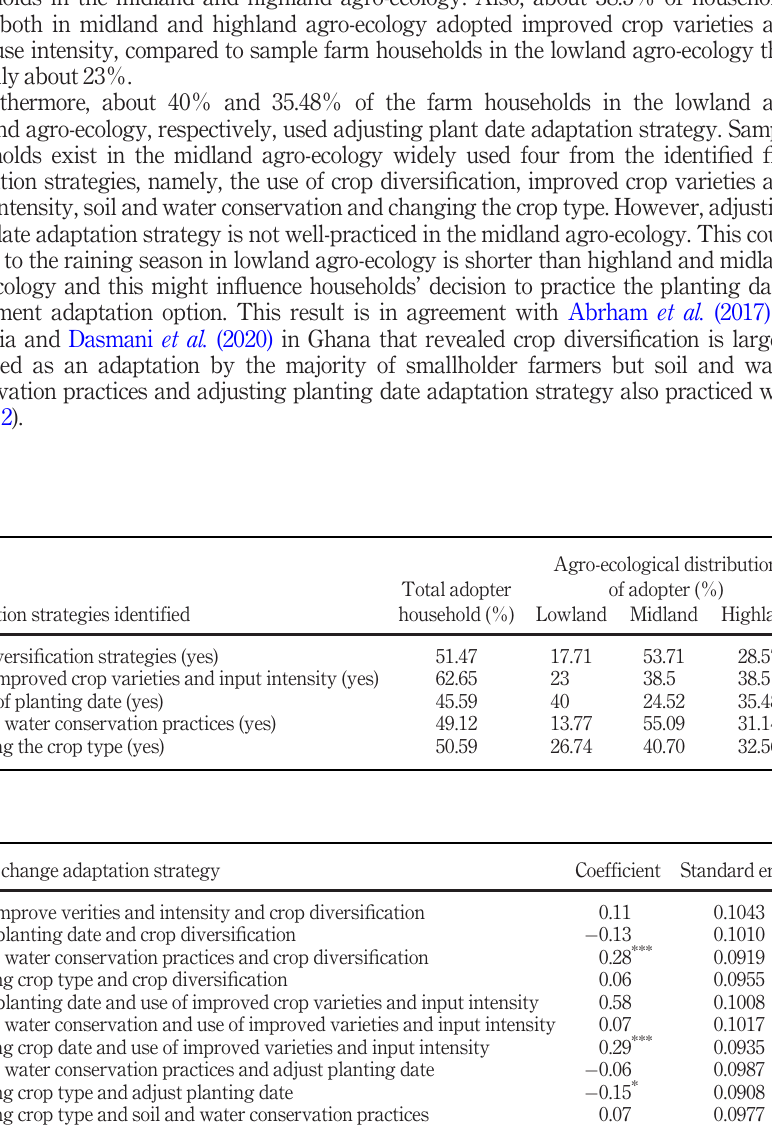
Table 3. Correlation matrix among farmers ’ adaptation strategies (from the multivariate probit estimation)